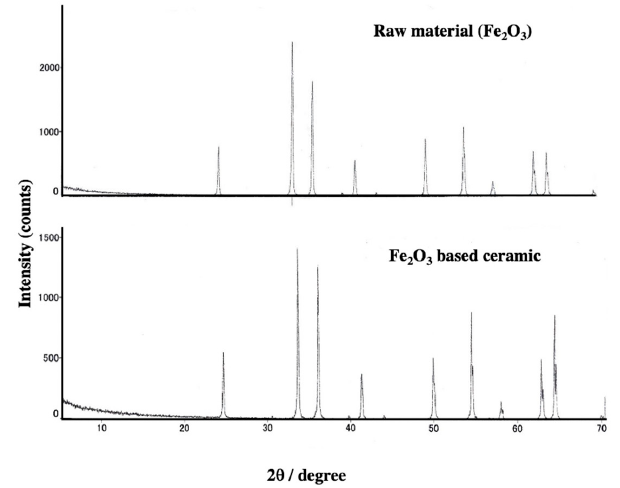
ff raction profiles of Iron (III) oxide raw material and fired Figure 1. X-ray diffraction profiles of Iron (III) oxide raw material and fired ceramic. Figure 1. X-ray di